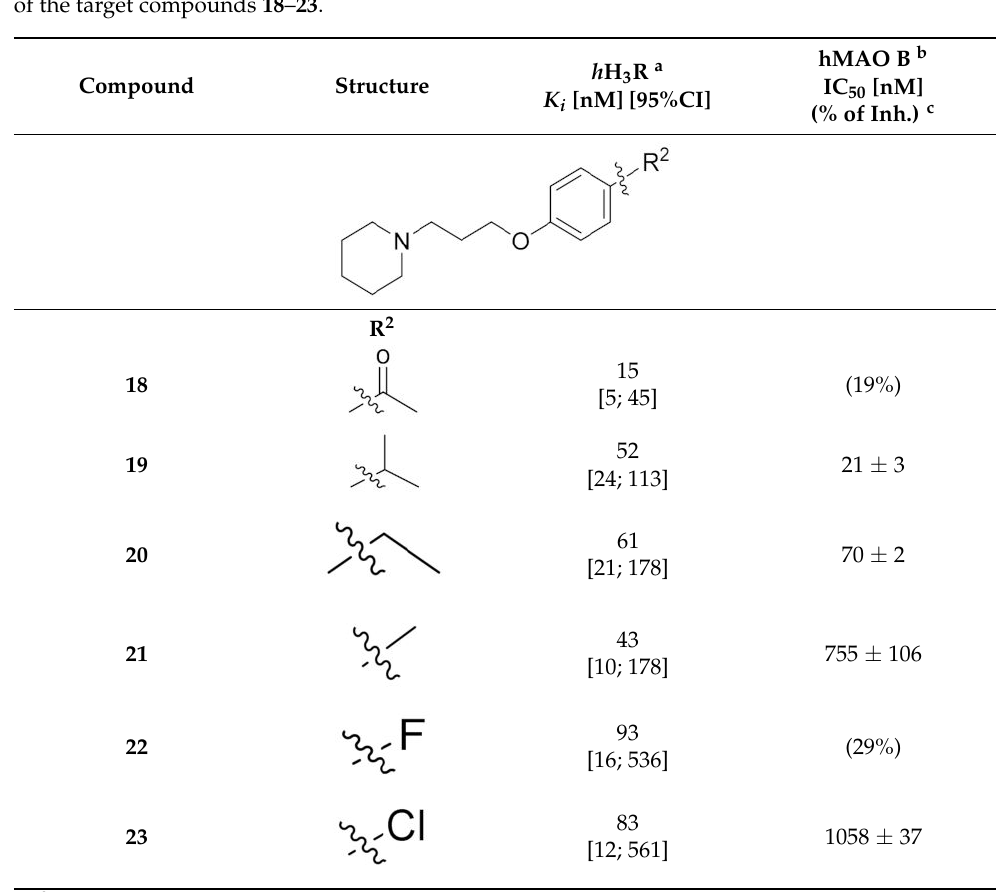
Table 2. In vitro affinities for human histamine H 3 receptor and human MAO B inhibitory activities of the target compounds 18 – 23